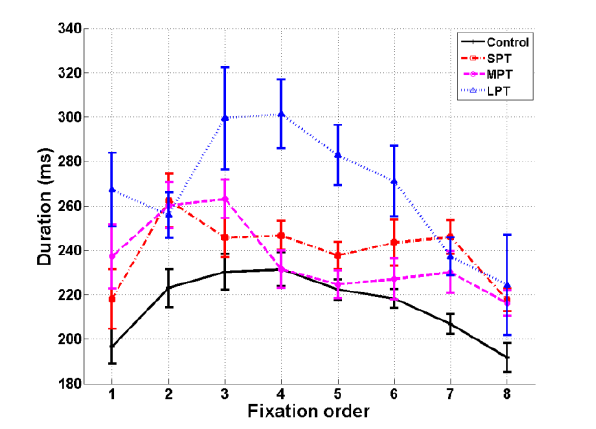
Figure 3: Mean fixation duration in milliseconds as a function of fixation order (fixations 1 to 8) for the control condition and the three distractor conditions (SPT, MPT and LPT). Error bars represent standard error.